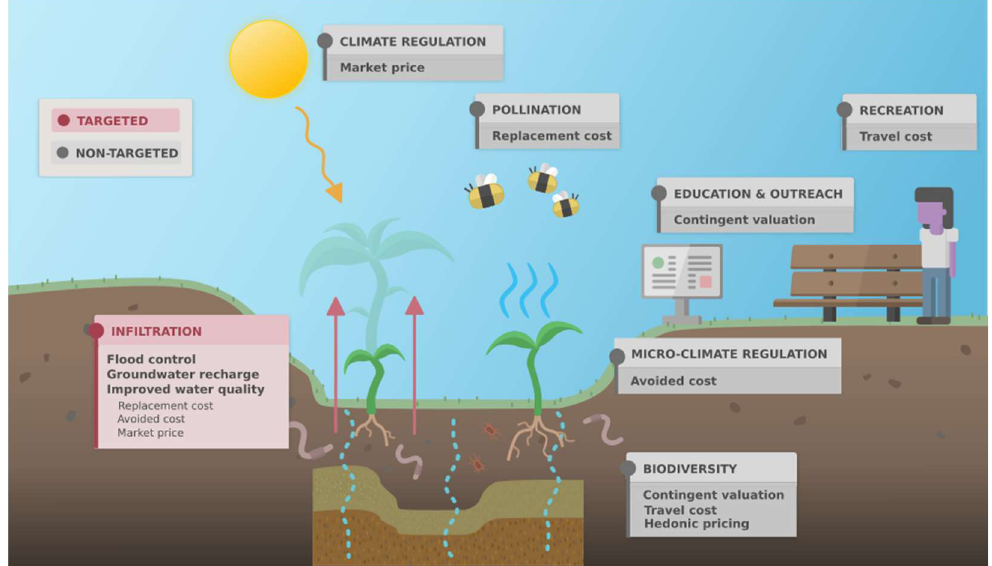
Figure 1. Diagram of targeted and non-targeted ecosystem services associated with natural stormwater treatment systems (a bioretention system pictured here) and methods used to assign a value to them.